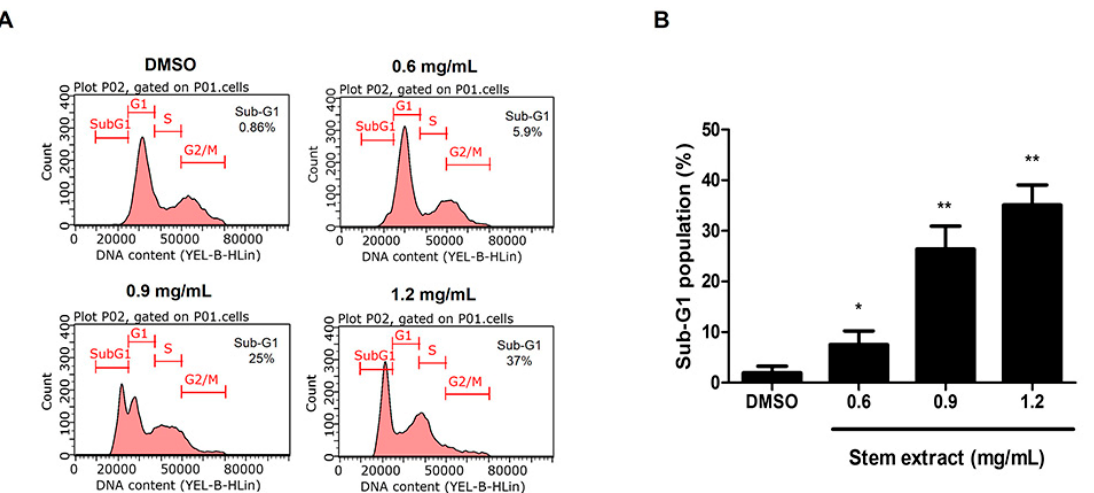
Figure 3. Sub-G1 peak analysis of PC-3 cells treated with stem extract. The flow cytometry analyzed PC-3 cells that were treated with stem extract at 0, 0.6, 0.9, and 1.2 mg/mL for 24 h. ( A ) Histograms demonstrate the number of cells (y-axis) vs. the DNA content (x-axis). The data shown are representative of three experiments with similar findings. ( B ) The quantitative values of the sub-G1 population. The significant differences of the treated cells from the untreated control group are indicated by * p < 0.05 and ** p < 0.01.